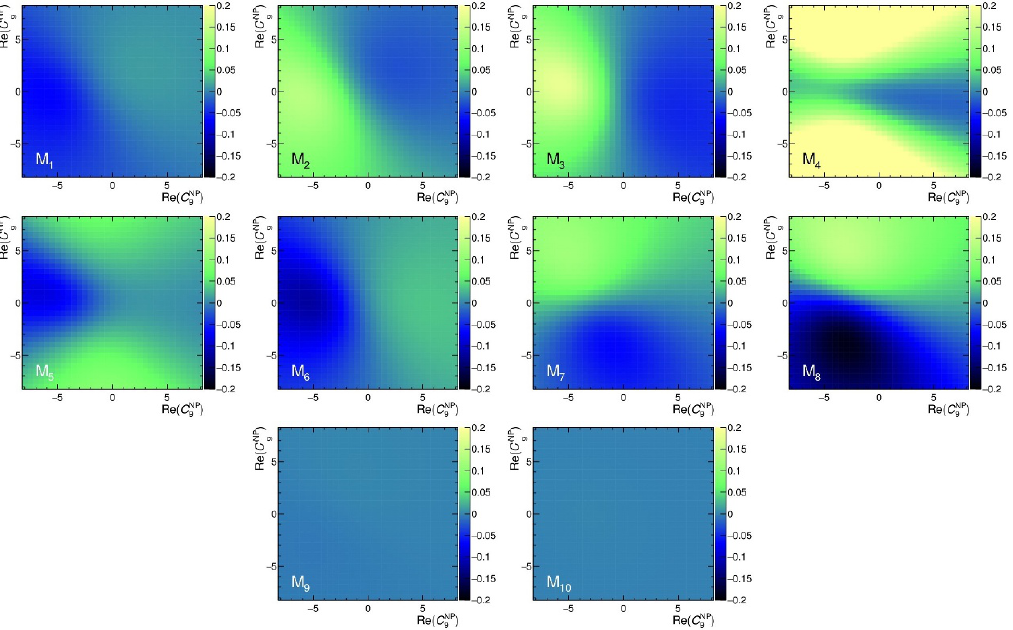
+ (cid:22) (cid:0) decay from their SM central 1 { M 10 of the (cid:3) b ! (cid:3) (cid:22) ). 9